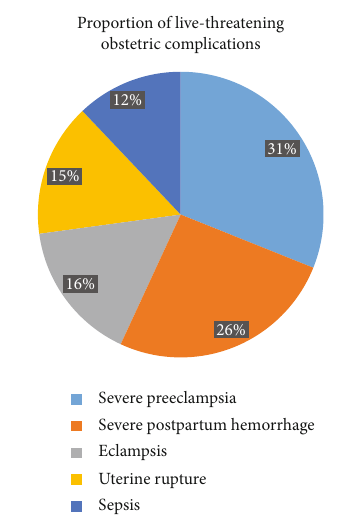
Figure 1: Six-year (2012-2017) average proportion of life- threatening pregnancy complications among mothers admitted in selected hospitals of North Shewa Zone, Central